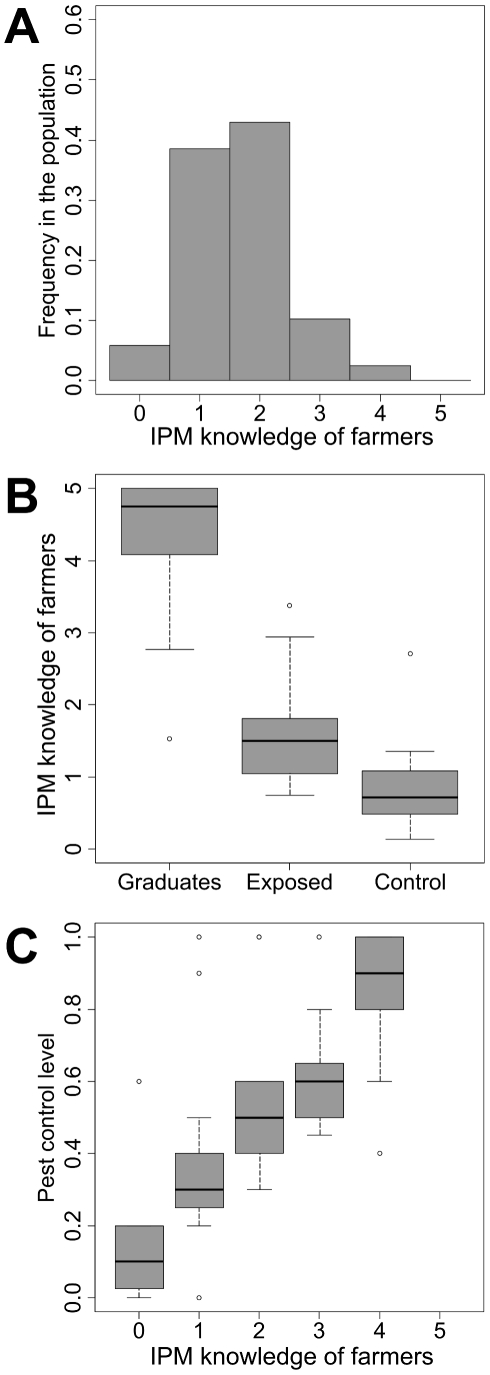
Field data.A. Distribution of IPM knowledge of farmers (n = 293 inquests) B. Efficiency of learning process between graduates and exposed farmers (n = 85). C. Relationship between IPM knowledge of farmers and pest control (n = 83 households) (linear model; R2 = 0.51, P<0.001).